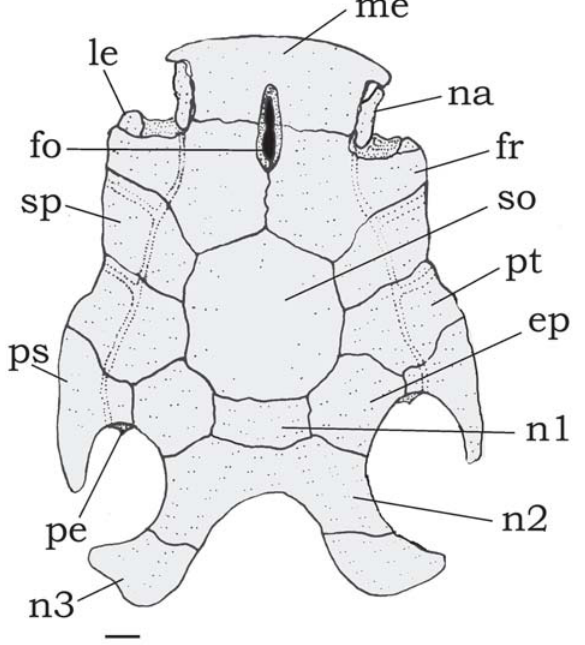
Fig. 20. Neurocranium of Tatia dunni , ANSP 71706, paratype, 50.1 mm SL. Dorsal view. Abbreviations: ep , epioccipital; fo , single cranial fontanel, fr , frontal; le , lateral ethmoid; me , mesethmoid; na , nasal; n1 , first nuchal plate, n2 ; second nuchal plate; n3 , third nuchal plate; pe , posterior epioccipital process; ps , posttemporal-supracleithrum; pt , pterotic; so , supraoccipital; sp , sphenotic. Scale bar = 1 mm.